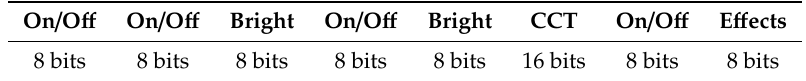
Table 9. Message body structure for light control